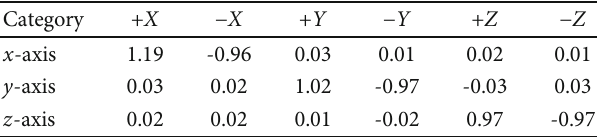
Table 4: Calibration results of three-axis